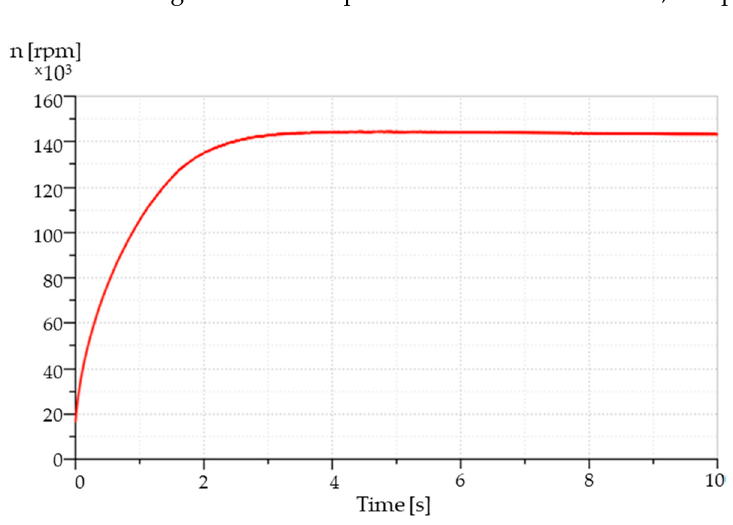
Figure 14. Turbocharger rotor speed variation simulated with AMESim software.